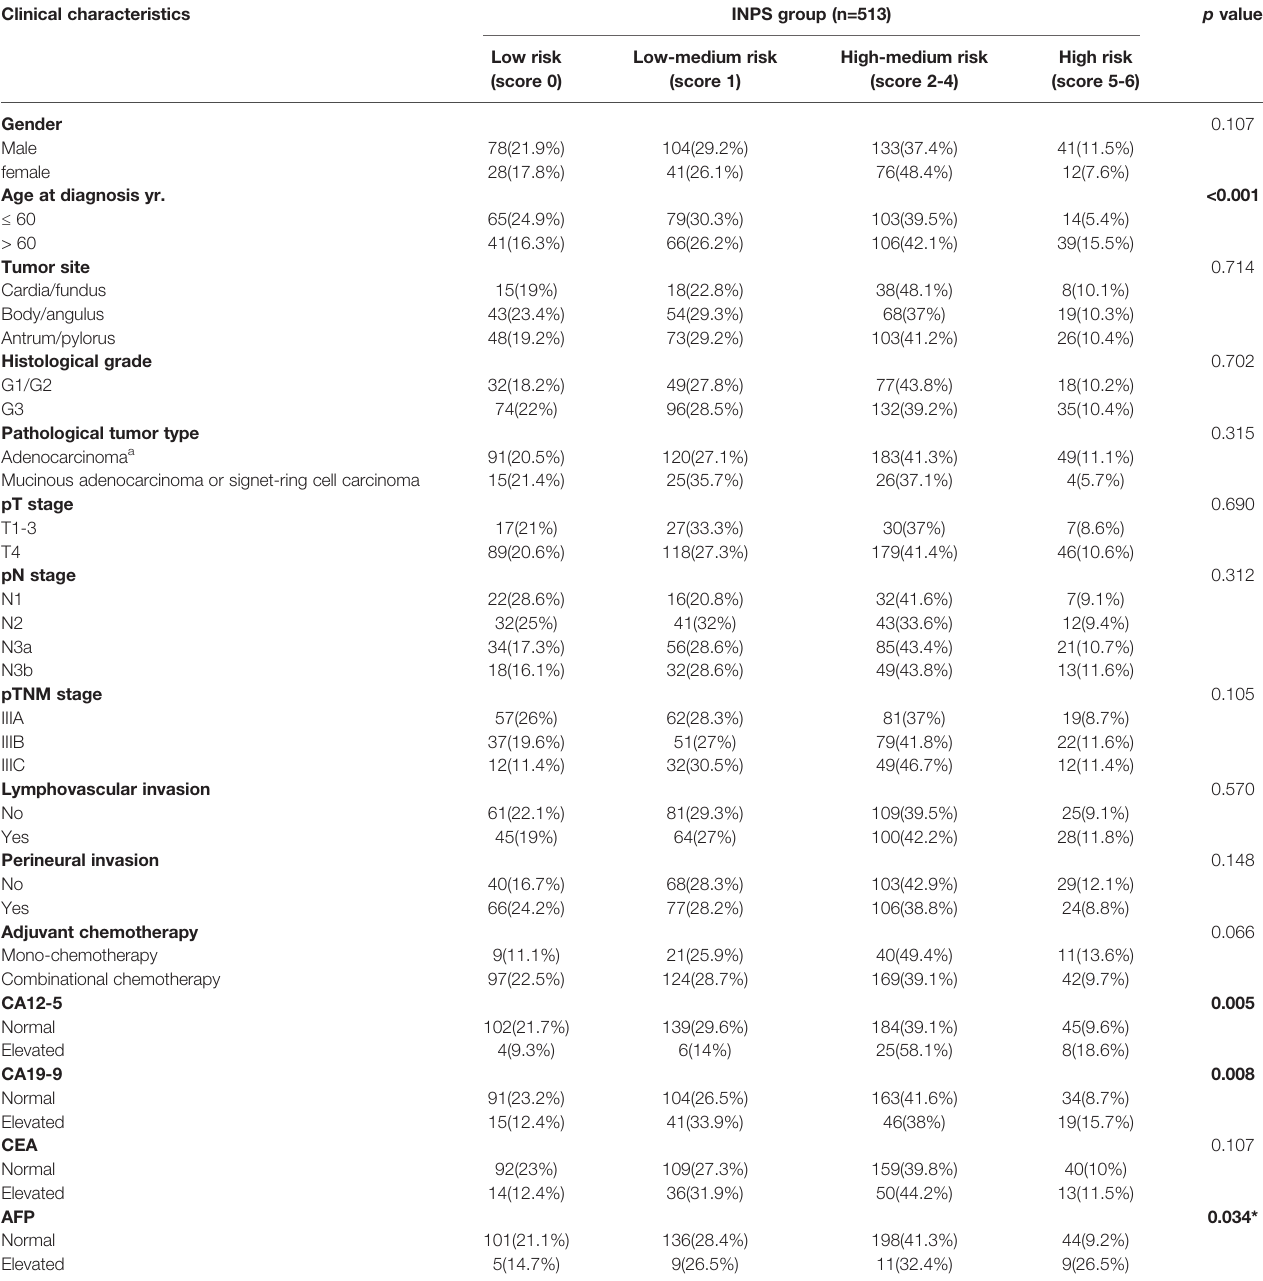
TABLE 3 | Association between the INPS group and clinical